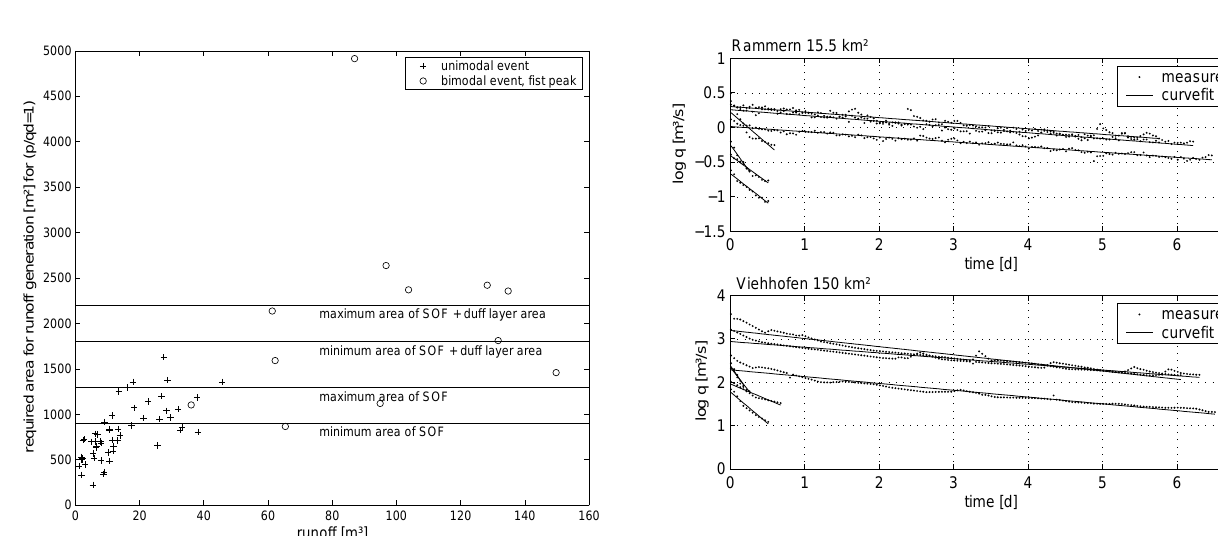
Fig. 8. Recession curves for the rainfall runoff events measured 1997 (every forth measured point is plotted) for Rammern and Viehhofen: linear model.